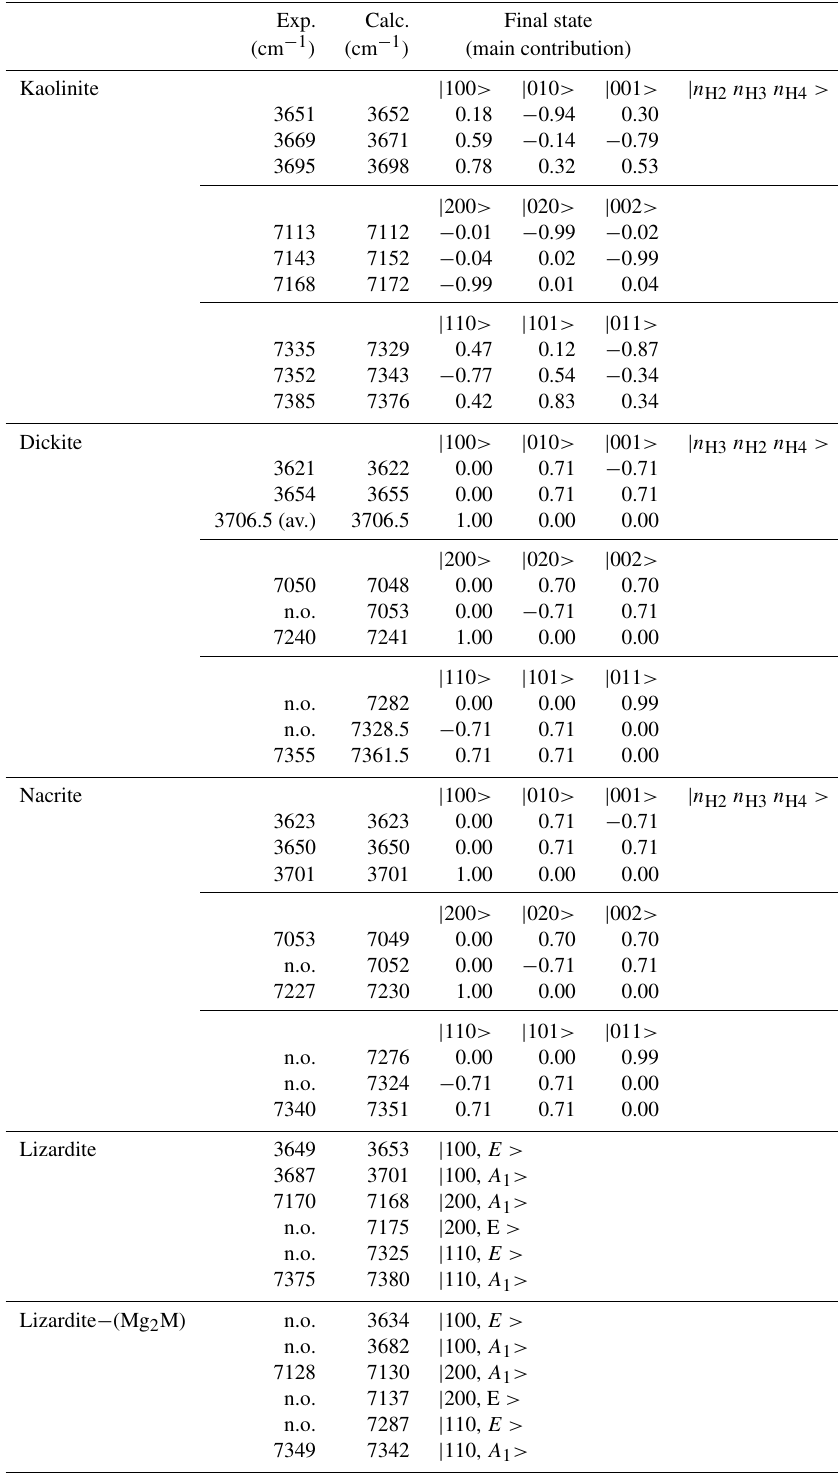
Table 3. Observed and calculated anharmonic frequencies of vibrational transitions involving interlayer OH in 1 : 1 phyllosilicates. The coefficients of the dominant contributions to the excited state are indicated. The quantum numbers refer to the isolated oscillators as indicated in the right